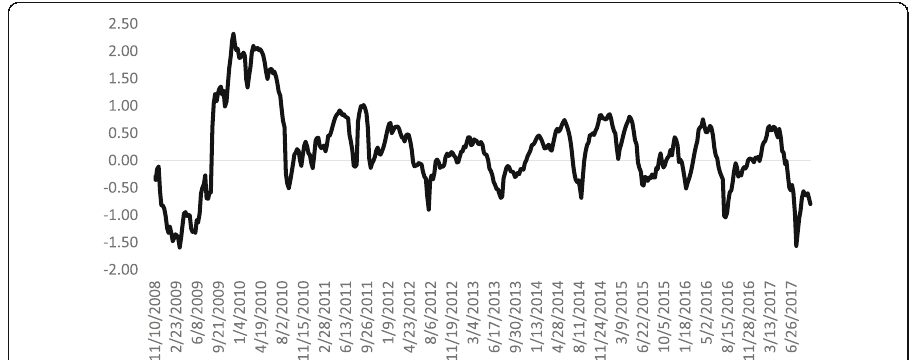
Fig. 1 Cointegrating Equation. The cointegrating equation revolves around zero (equilibrium). Deviations from the equilibrium allow for the use of a trading strategy to exploit the eminent return of the relationship to the equilibrium